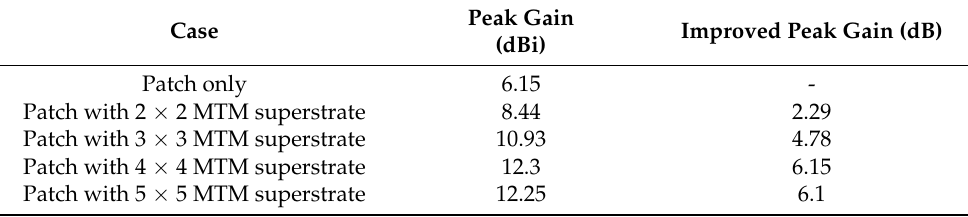
Figure 4. Simulated radiation patterns of the patch antenna with and without an MTM superstrate. Table 1. Simulated peak gains of the patch antenna without and with an MTM superstrate.